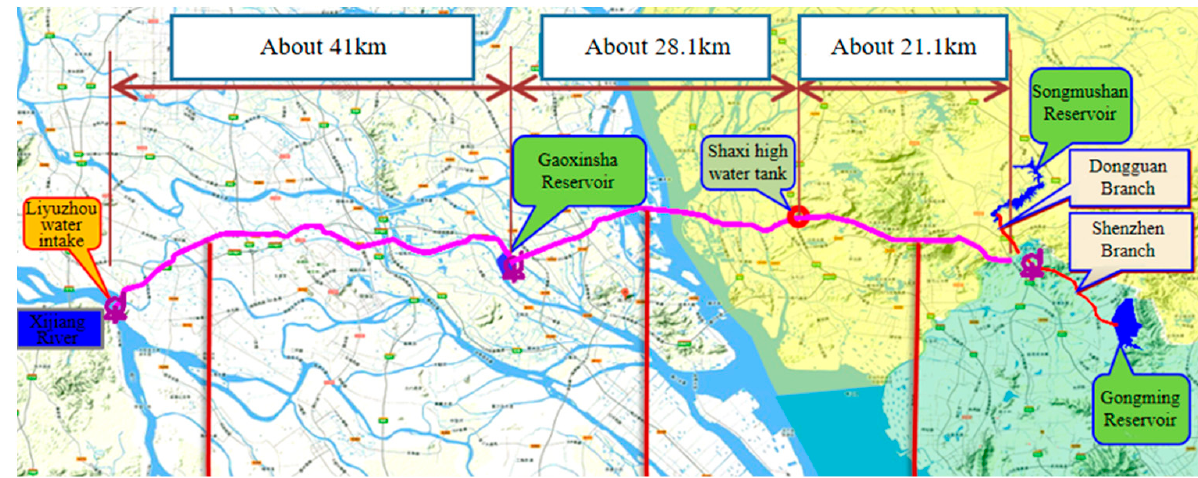
Figure 1. Layout sketch of water resources allocation project.